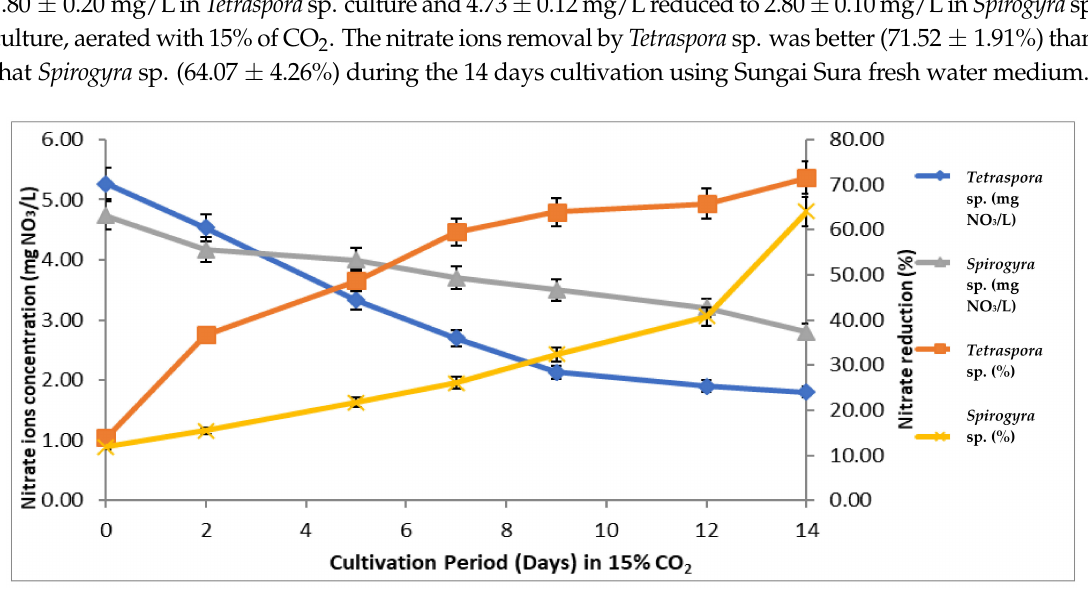
Figure 4. Nitrate ions (NO 3 − ) concentration profile during the 14 day cultivation period for Tetraspora sp. and Spirogyra sp. aerated with 15% CO 2